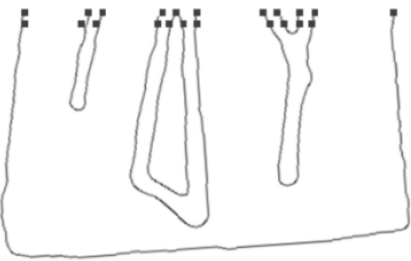
Figure 11. Selection of encoding points for underwater images of obstacles. Normalized chain code is conducive to the unique representation of a code point, but it does not have rotation invariance. In the process of image stitching, it is required that the chain code belonging to a certain edge is unique and does not change after moving and rotating. Normalized differential code has this characteristic. Therefore, in order to obtain the chain code that meets the stitching requirements, the original code needs to be differentiated and then normalized to obtain the normalized differential code. Next, taking the original code of the underwater image of the obstacle as an example, the solution of the normalized differential code is carried out, as shown in Figure 12.